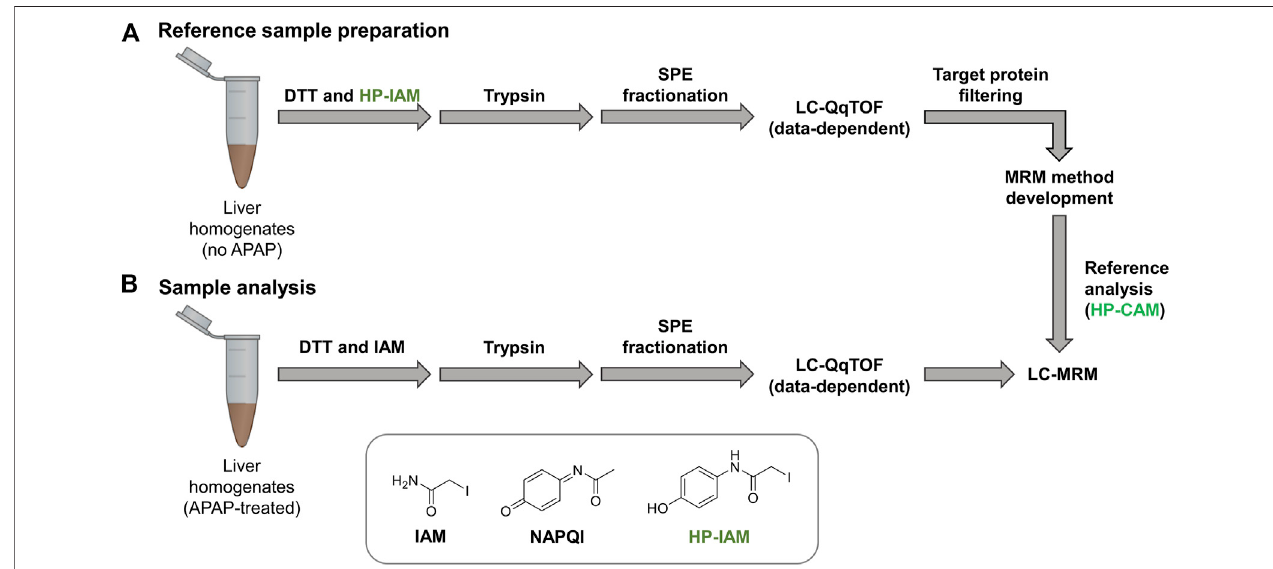
FIGURE 1 | Reference samples (A) were prepared using non-treated mouse and rat liver homogenates and HP-IAM as the cysteine alkylation reagent. Modi fi ed peptidesofinterestfrompotentialproteintargetswereselectedforMRMmethodpreparation.FinalLC-sMRMmethodswereusedtoscreenformodi fi edpeptidesin (B) APAP-treated samples. Data-dependent high-resolution MS/MS experiments were performed on reference samples as well as selected APAP-treated rat and mouse samples for identifying modi fi ed peptides via database searching with custom modi fi cation (+C 8 H 7 NO 2 addition onto Cys residues).